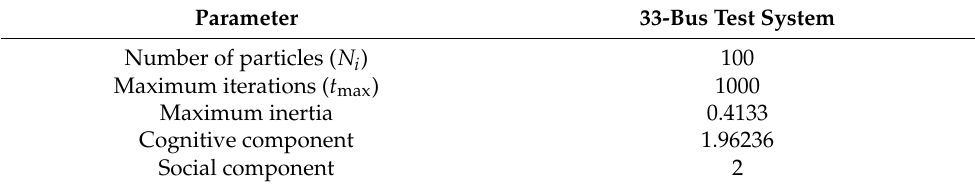
Table 2. DCPPSO parameters.